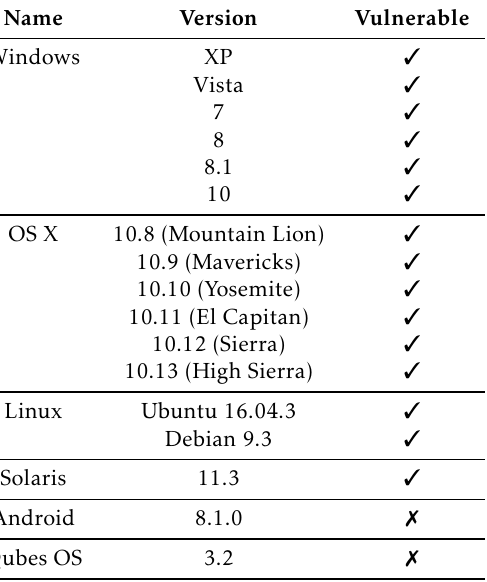
Table 1. Compatibility of Mouse Underlaying with operating